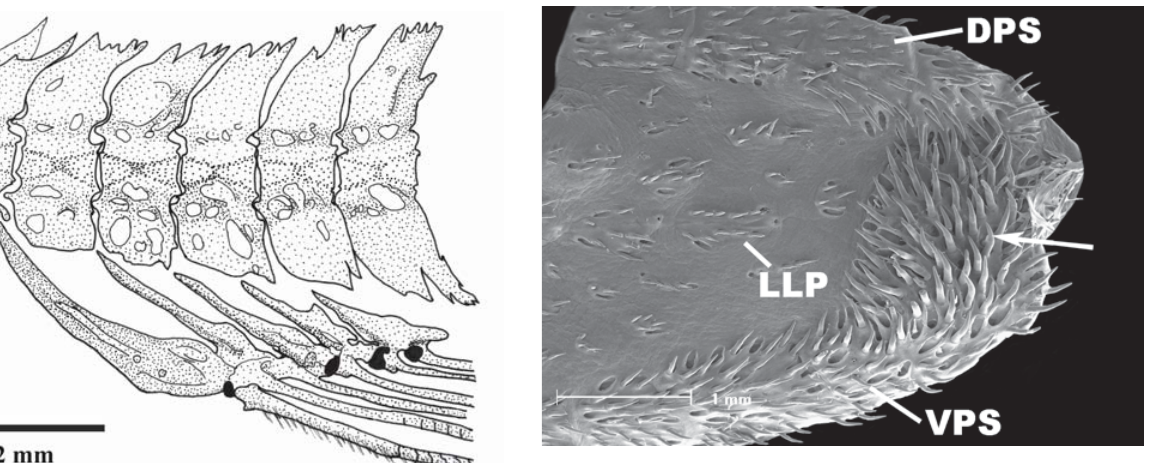
Fig. 4. Scanning electron microscope image of dermal plates at posterior end of caudal peduncle. Gymnotocinclus anosteos , paratype, MCP 41726, male, 40.5 mm SL. LLP = lat- eral line plates, VPS = ventral plate series, DPS = dorsal plate series. Arrow indicates the modified odontode tips of the last plates on caudal